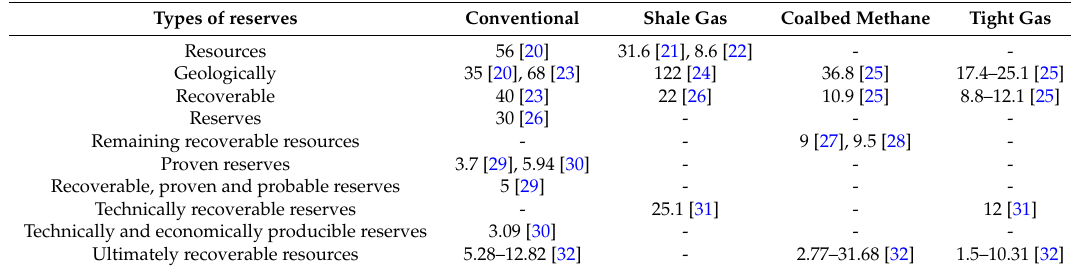
Table 1. Natural gas resource endowment (in tcm) in China.